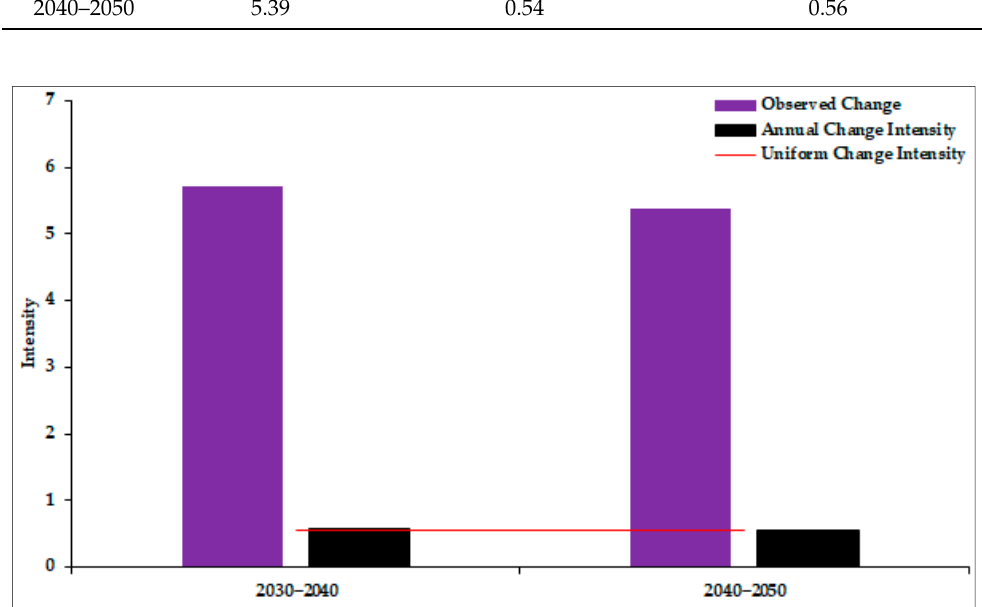
Figure 15. Change intensity from 2030–2050.